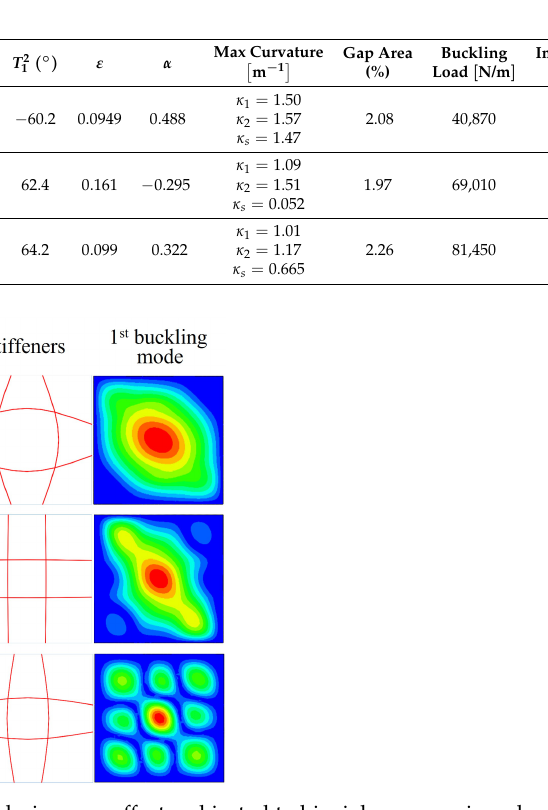
Figure 15. Optimized panels considering gap effect, subjected to biaxial compression plus